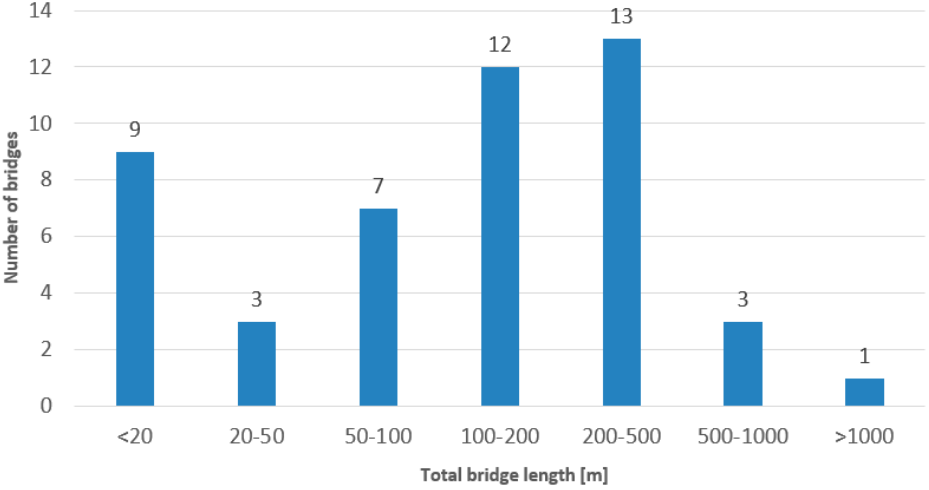
Figure 3. Distribution of bridge in total length classes. The static scheme is mainly represented by the simply supported one (42 bridges). The continuous span is used only in one case (Figure 4).